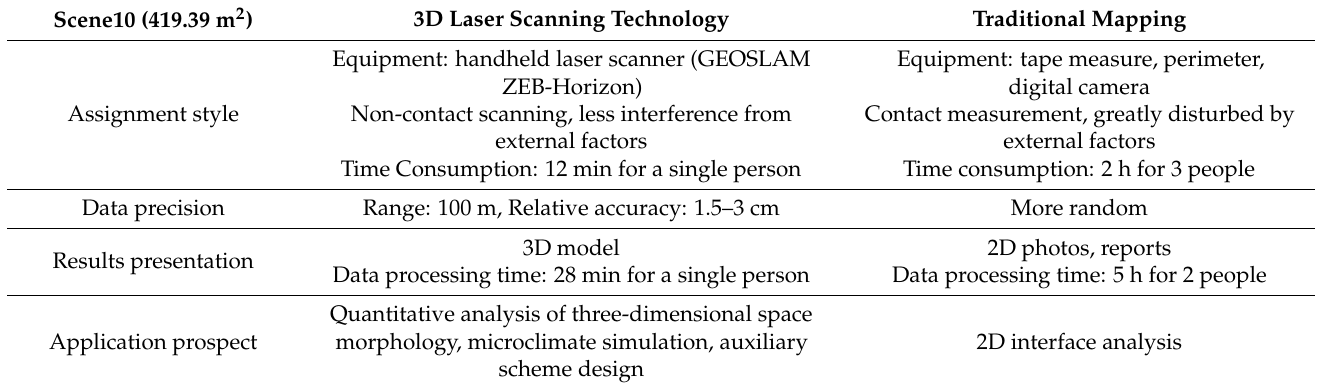
Table 5. Comparison of laser scanning technology and traditional surveying and